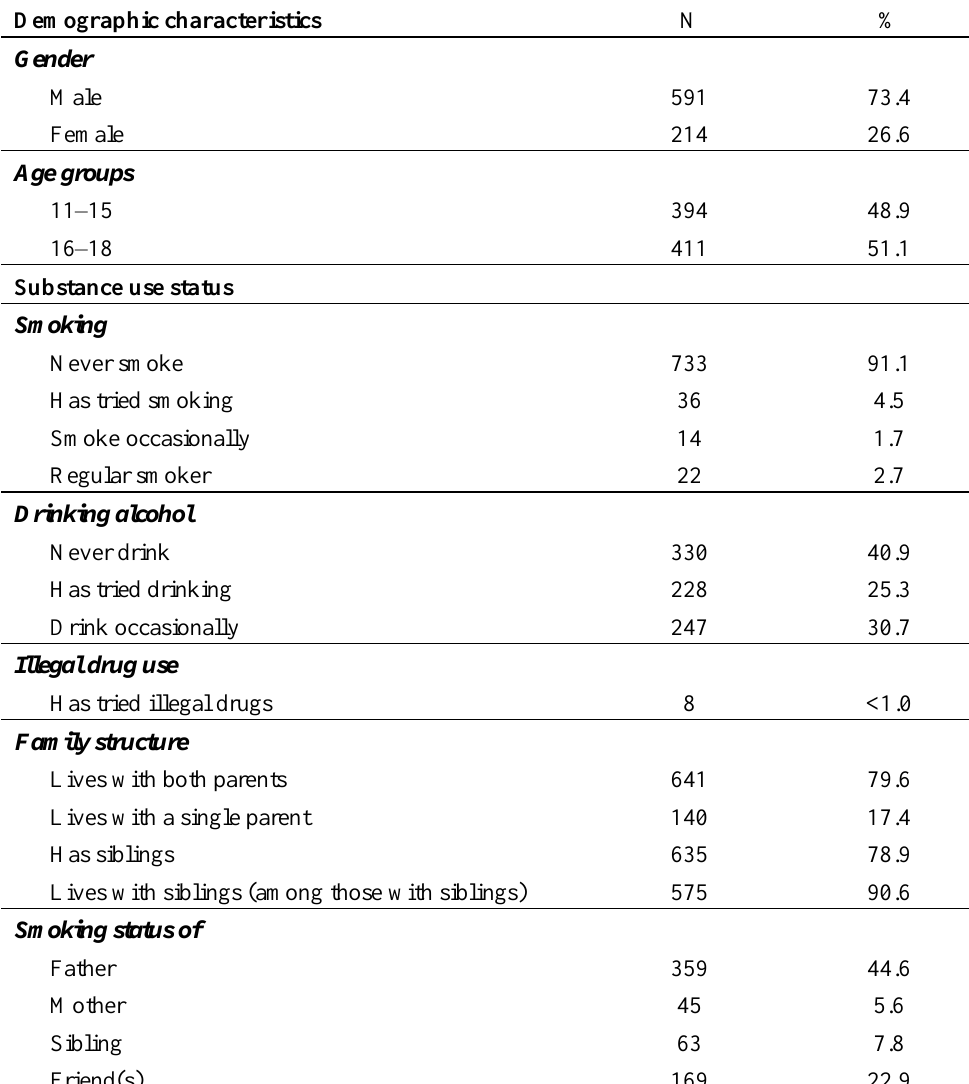
Table 1. Demographic Characteristics of the Adolescents in the Study ( n =